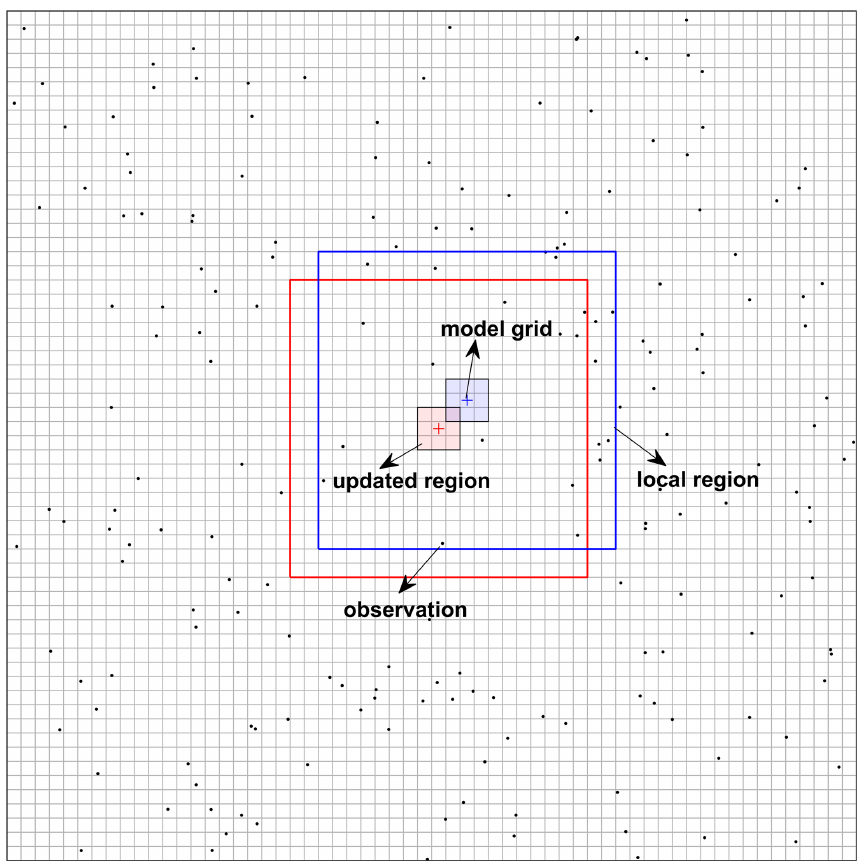
Figure 2. Illustration of the local analysis scheme used in the assimilation. The plus and dot symbols denote the centres of the model grids and the location of the observation sites, respectively. The large rectangular region denotes the local region, and the shaded region denotes the updated